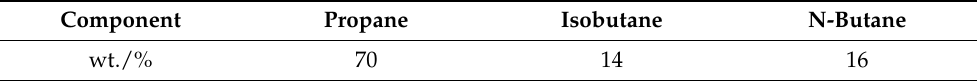
Table 1. The components of LPG.